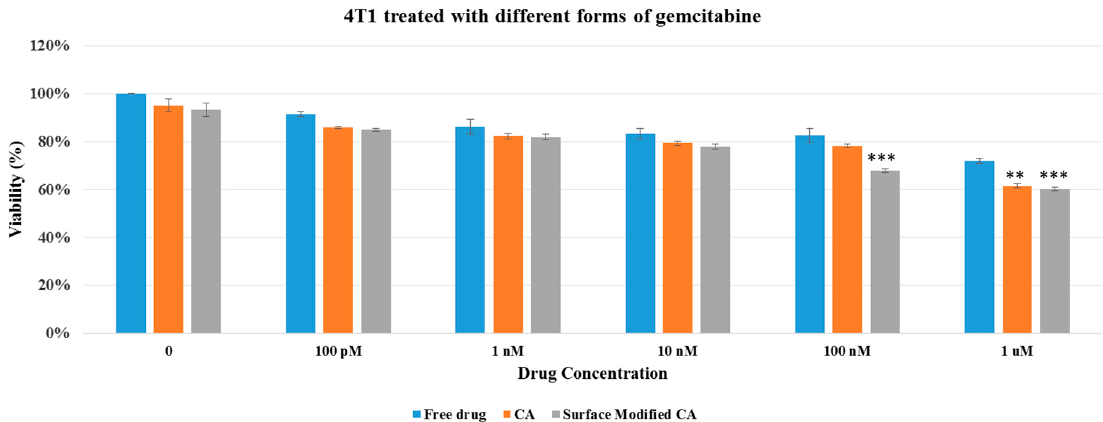
Figure 6. Cell viability of 4T1 after 48 h of treatment with gemcitabine-loaded CA and surface modified, gemcitabine-loaded CA. Surface-modified CA denotes the particles modified with streptavidin–biotin–PEG and fibronectin. Values were very significant (**) at p value 0.001 to 0.01, and extremely significant (***) at p value 0.0001 to 0.001. Table 3. Enhancement of cytotoxicity (%) for gemcitabine-loaded CA particles in MCF7. 100 pM Uncoated Table 4. Enhancement of cytotoxicity (%) for gemcitabine-loaded CA in 4T1. 100 pM